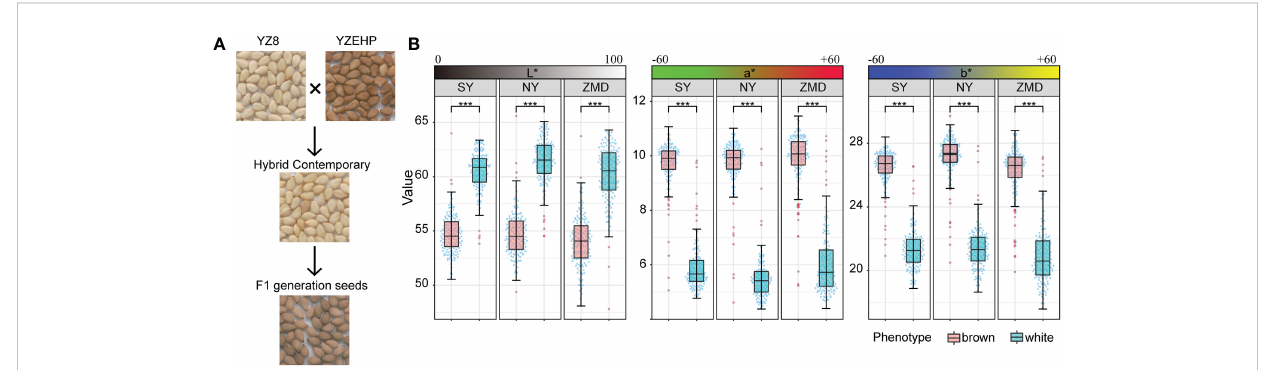
FIGURE 1 Phenotypic analysis of parents and RILs. (A) Seed coat color of the parents and hybrid offspring. (B) Distribution of quantitative values of L*, a*, and b* in the RIL population, Signi fi cant levels were determined by T-test, with *** representing p <0.001